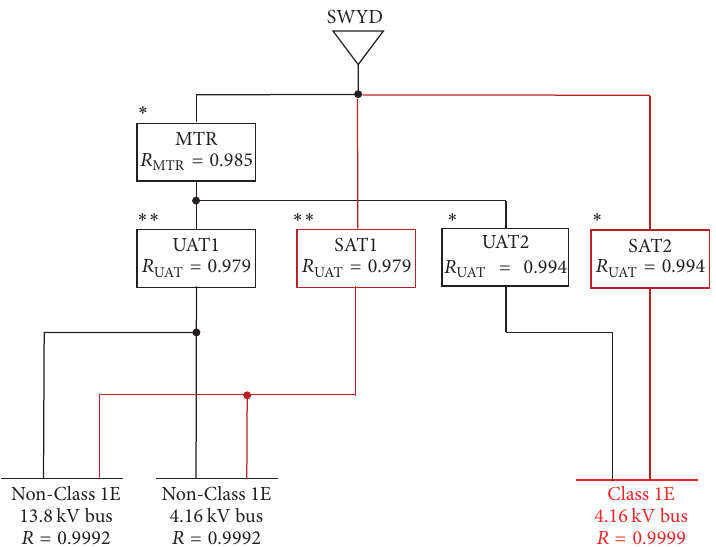
Figure 8: Reliability of modified electric power system. ∗ Two-winding transformer. ∗∗ Three-winding transformer.